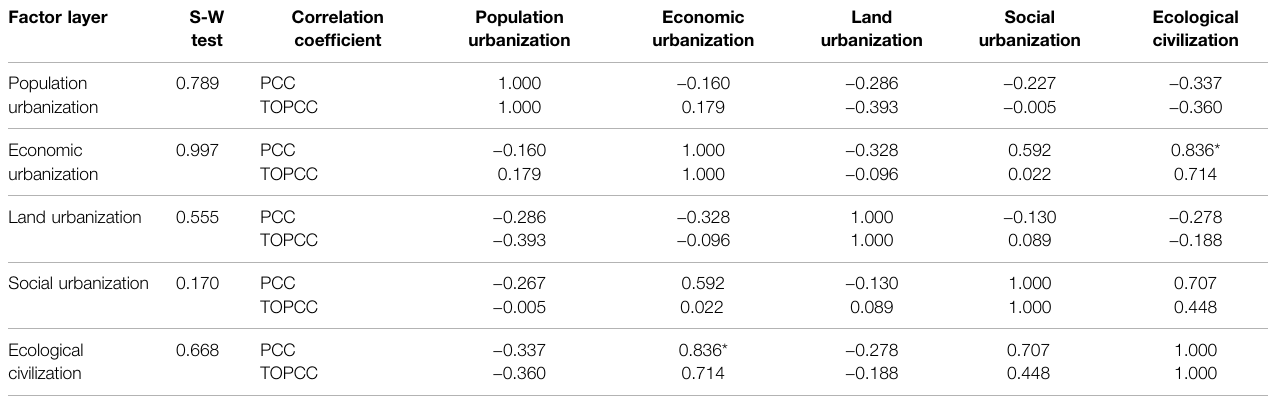
TABLE 2 | Correlation coef fi cients of each factor